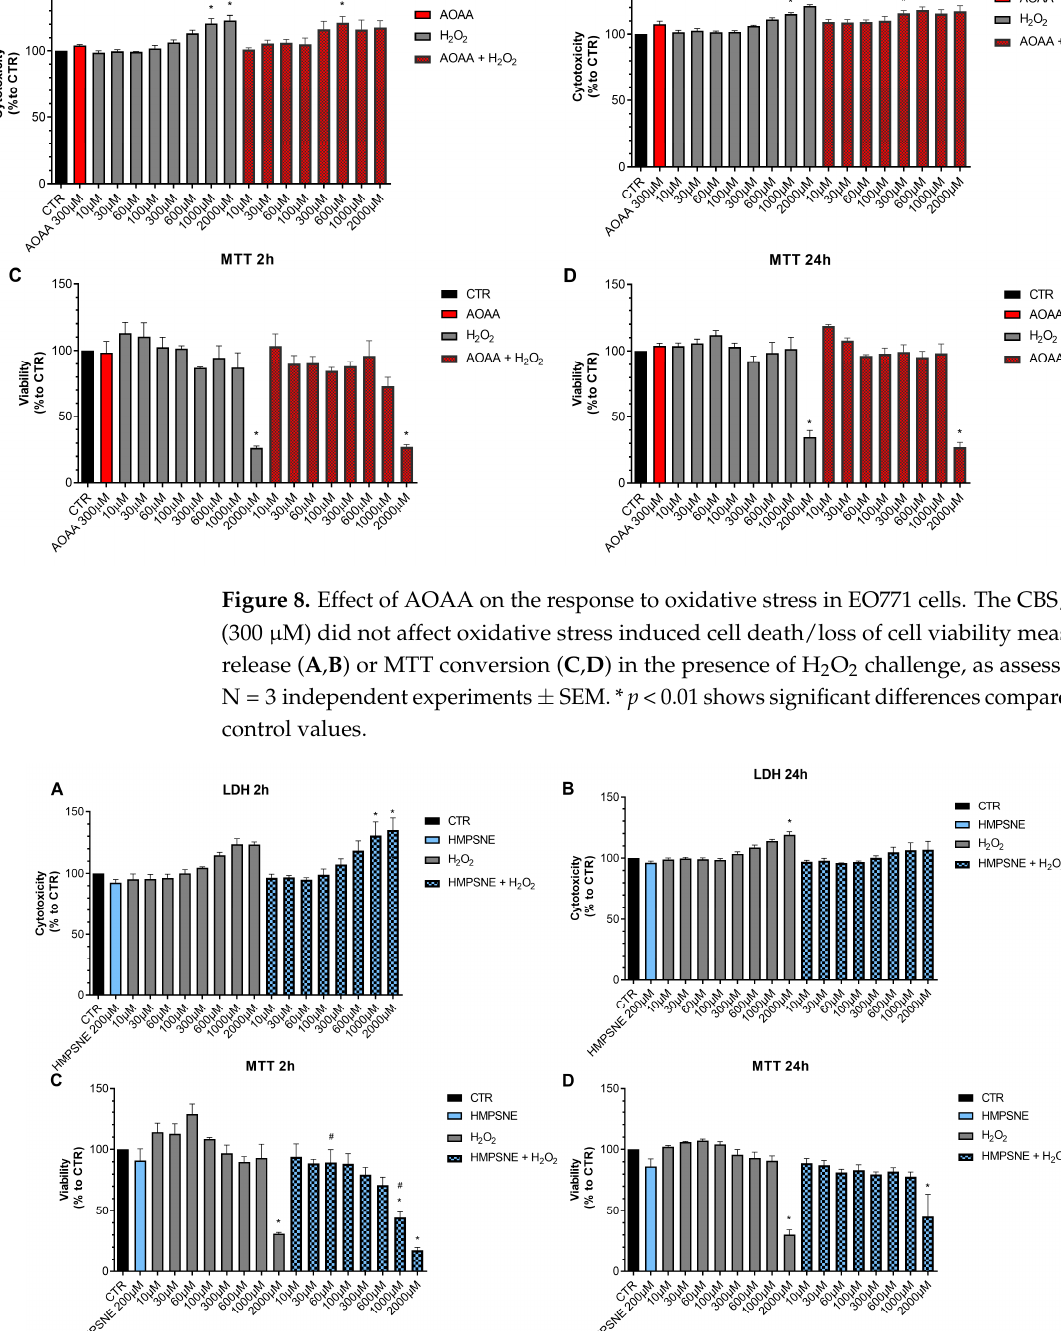
Figure 9. Effect of HMPSNE on the response to oxidative stress in EO771 cells. The 3-MST inhibitor (300 µ M) did have a marked overall effect on oxidative stress induced cell death/loss of cell viability measured by LDH release ( A , B ) or MTT conversion ( C , D ), as assessed at 2 or 24 h. Nevertheless, at 2 h, in the presence of at 60 and 1000 µ M H 2 O 2 , HMPSNE tended to exacerbate the degree of cell dysfunction, assessed by the suppression of MTT converting-ability (# p < 0.05 represents significant difference in MTT or LDH at the same concentration of H 2 O 2 , in the presence vs. absence of 300 µ M HMPSNE). N = 3 independent experiments ± SEM. * p < 0.05 shows significant effects of H 2 O 2 compared to untreated control